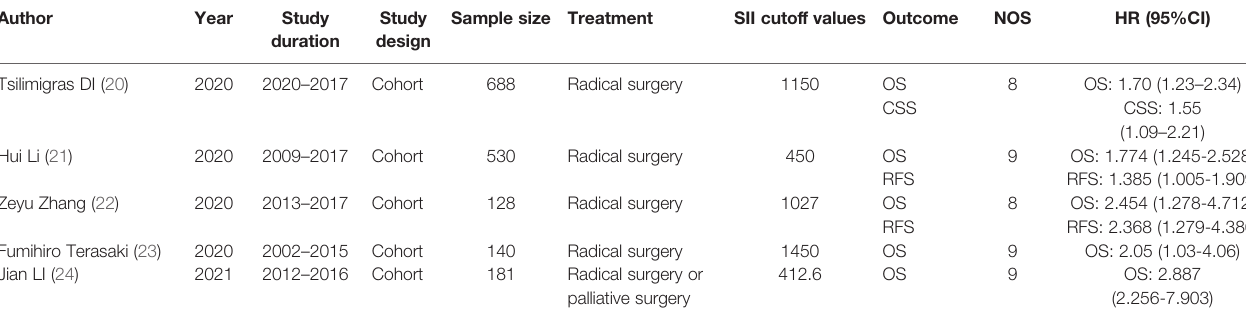
TABLE 1 | Main characteristic of the included